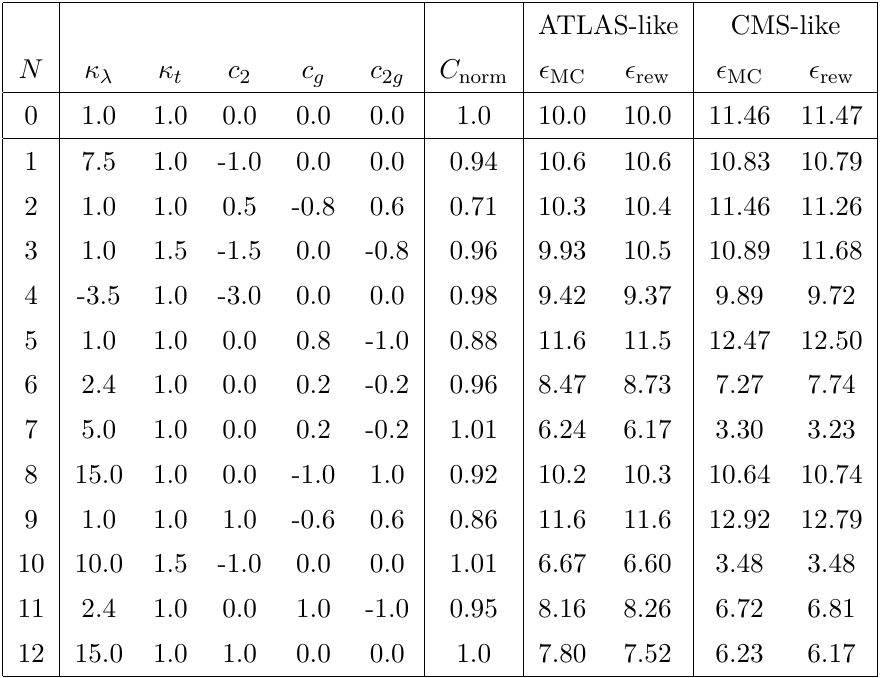
Table 4 . The renormalization factor ( C norm ) for benchmark point N as well as MC and reweighted sample efficiencies.